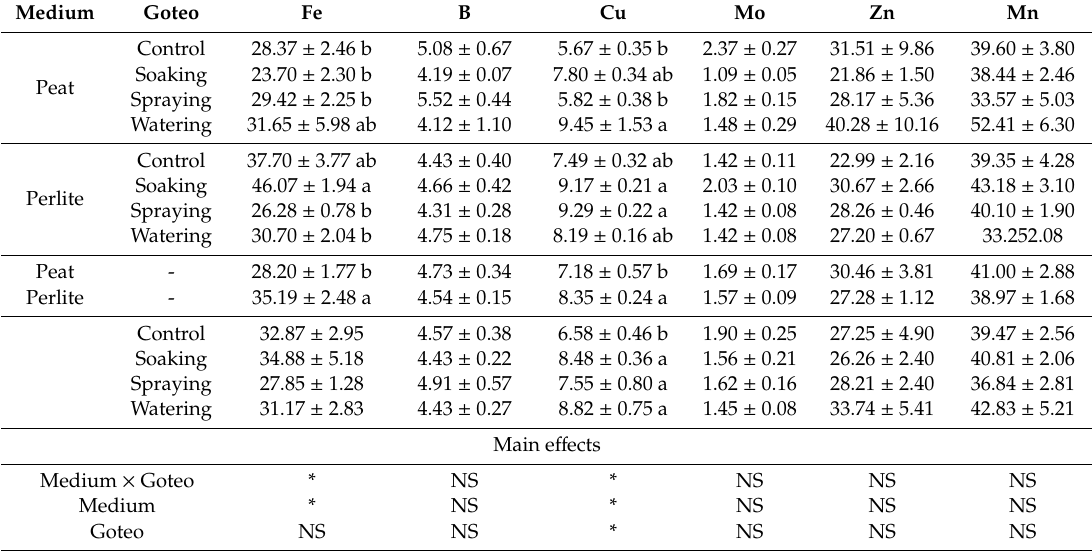
Table 5. Mineral composition of Pennisetum ‘Vertigo’ leaves after 2 months of pot cultivation: microelements (mg kg − 1